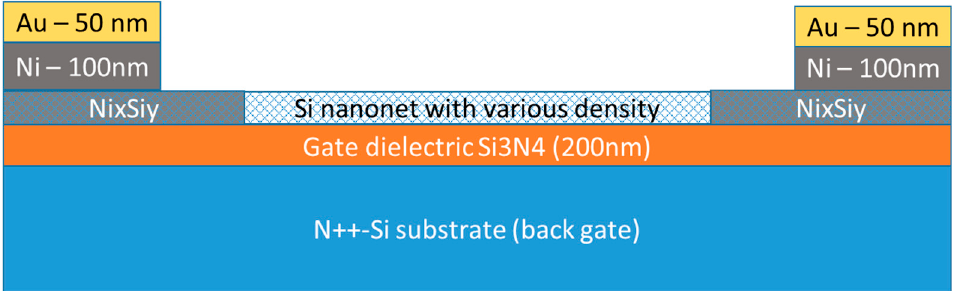
Figure 1. Cross-Section of Si Nanonet FET.